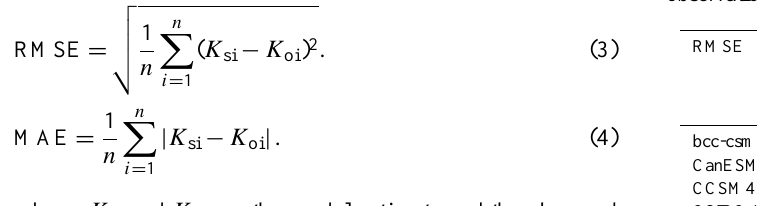
Table 2. The value of RMSE for precipitation and temperature with observation data from 1950 to